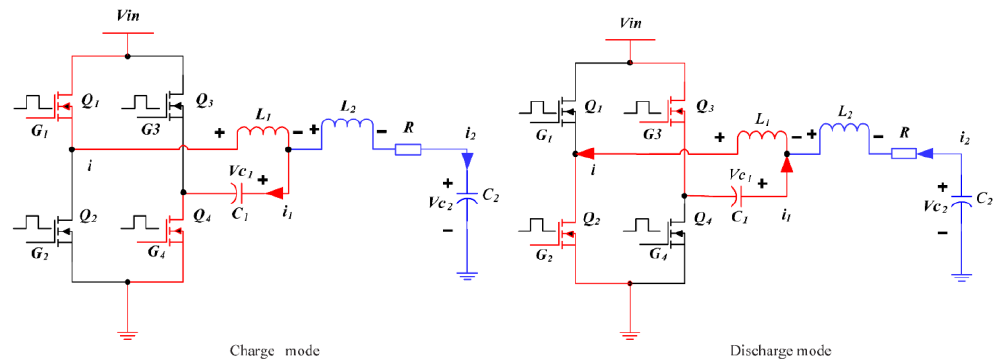
Figure 6. Relevant voltage and current operating waveforms.